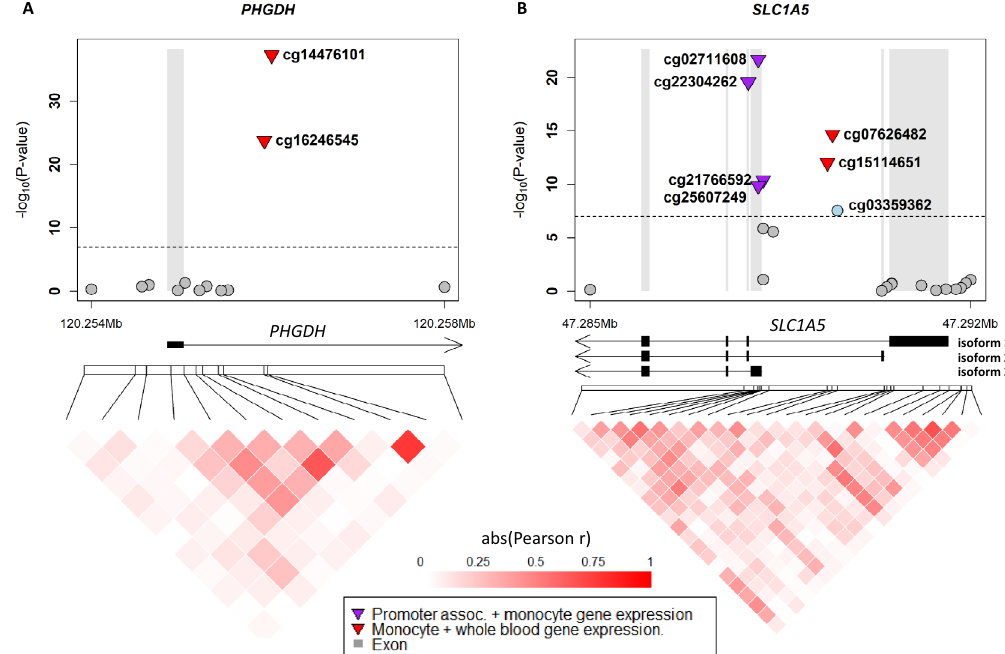
Fig. 3 Associations of CpGs at PHGDH and SLC1A5 with serum urate levels. For both PHGDH ( A ) and SLC1A5 ( B ), the upper part shows chromosomal positions on the x-axis and the – log10(p value) on the y-axis, and the lower part shows the correlations between DNA methylation levels of the CpGs. The replicated CpGs are labeled. Promoter-associated annotation was based on the HM450K annotation fi le. The gene models were based on RefSeq curated genes. Associations of DNA methylation with monocyte gene expression were from Kennedy et al. BMC Genomics 2018 and with whole blood from the KORA study (Methods). The correlations between the CpGs were generated using DNA methylation data from 804 European American participants of the ARIC study. Gene models were based on Genbank RefSeq (Accession numbers. PHGDH , NM_006623; SLC1A5 isoform 1, NM_005628; isoform 2, NM_001145144; isoform 3 NM_001145145). assoc.